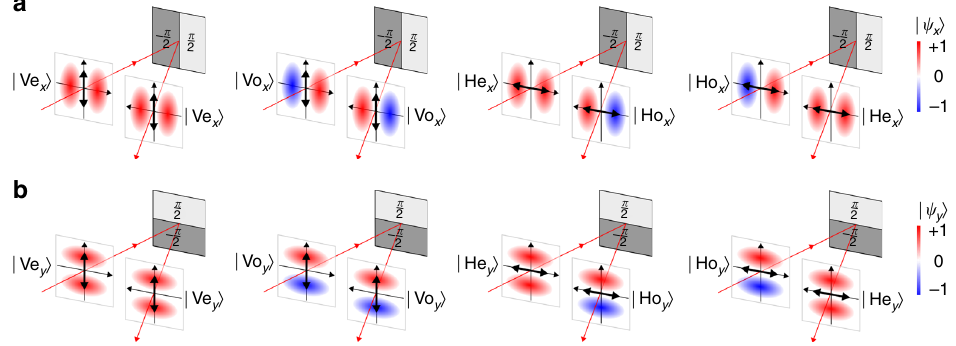
Fig. 2 Impact of a polarization-sensitive phase-only SLM on polarized single-photons. a Impact of a polarization-sensitive phase-only SLM on x -parity. The SLM imparts a phase step π along x . When the polarization is horizontal H j i , the SLM phase modulation results in a fl ip in the x -parity: e x j i → i o x j i and -parity. The SLMs in a and b can thus be viewed as two-qubit quantum logic gates where polarization is the control qubit and x - or y -parity is the